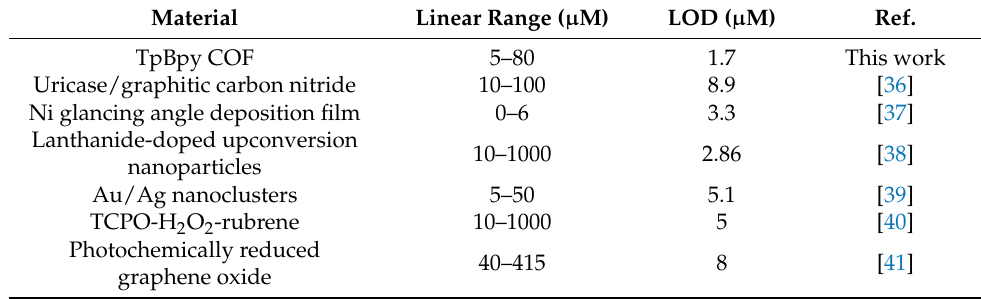
Figure 5. ( A ) UV ‐ vis spectra of the TpBpy COF + TMB system toward different concentrations of UA (from up to down: 5, 10, 20, 30, 40, 50, 60, 70, and 80 μ mol L − 1 ) Insert: the images of the corresponding solutions. ( B ) The linear relationship between the absorbance difference (A 0 − A) and UA content (A 0 and A represented the absorbance at 652 nm in the absence/presence of UA). ( C ) The response of TpBpy COF + TMB system towards UA and various interferences. ( D ) The signal response of TpBpy COF + TMB system towards UA coexisting with other substrates. The concentration of UA was 100 µ mol L − 1 , IgG and Alb was 1 mg L − 1 and the concentration of other interferences was 1 mmol L − 1 . Table 3. The analytical performance of reported materials for UA